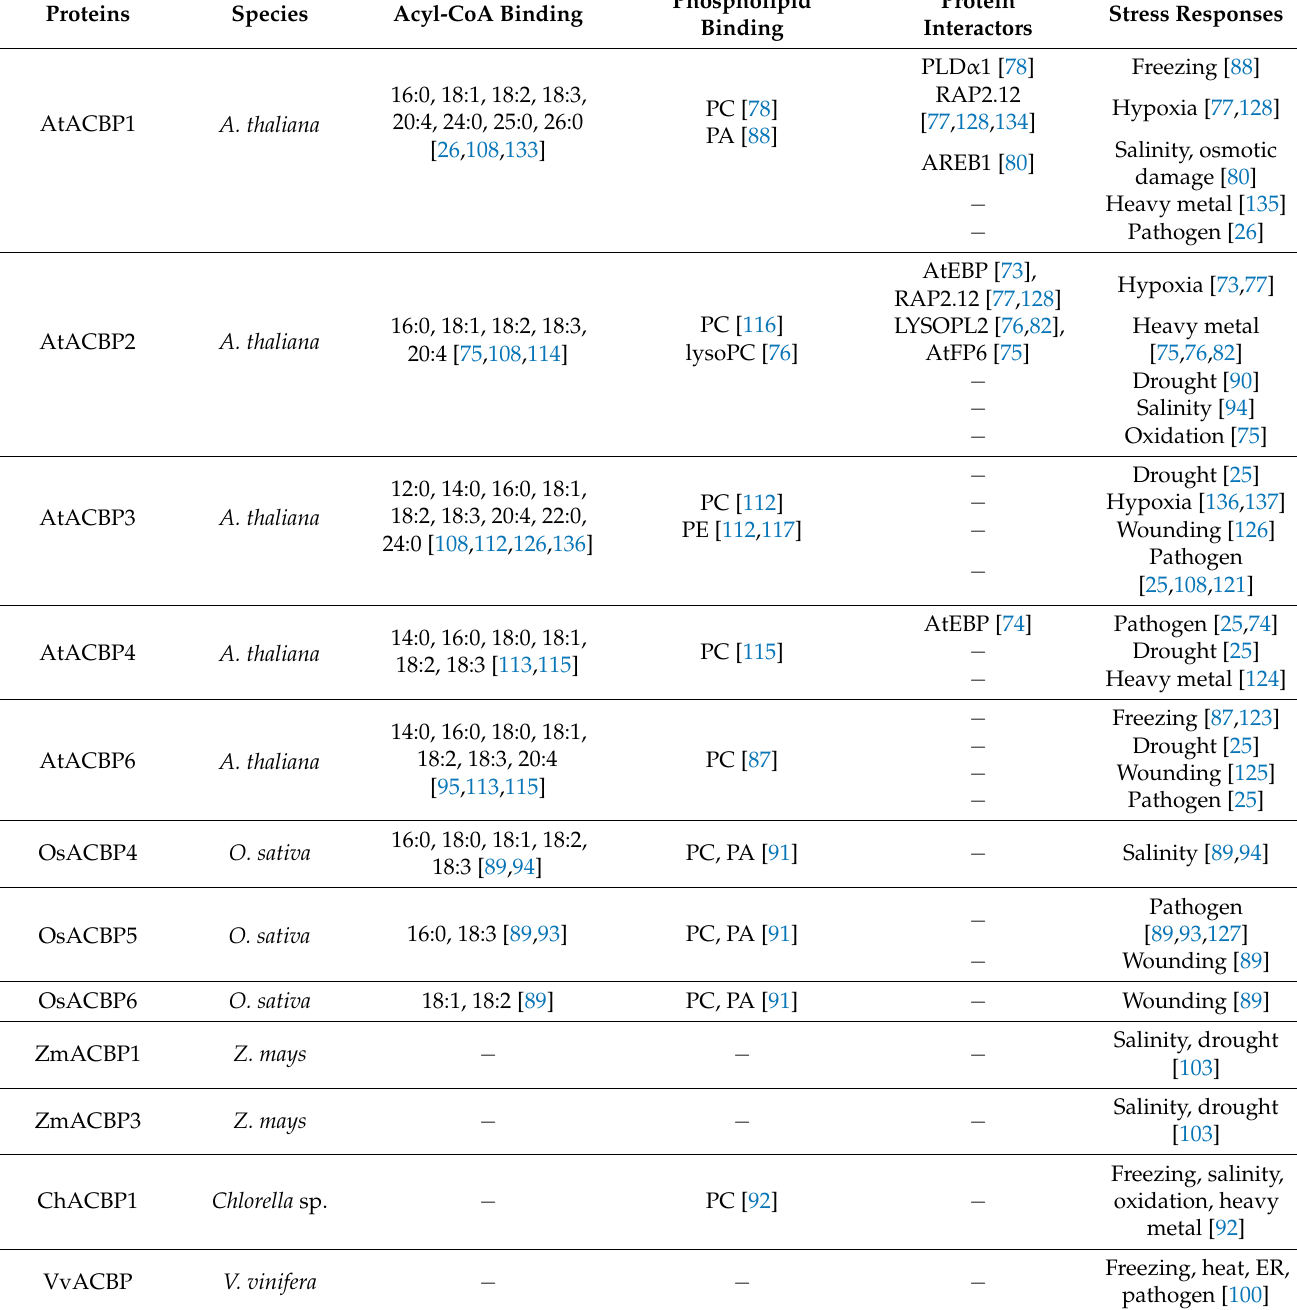
Table 2. Abiotic and biotic stress responses mediated by plant ACBPs and/or their interactors. Proteins